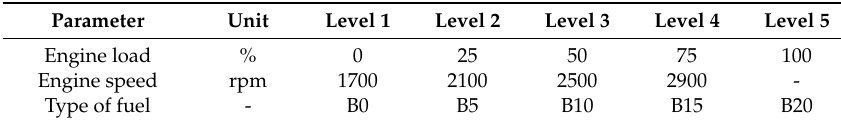
Table 4. Matrix of